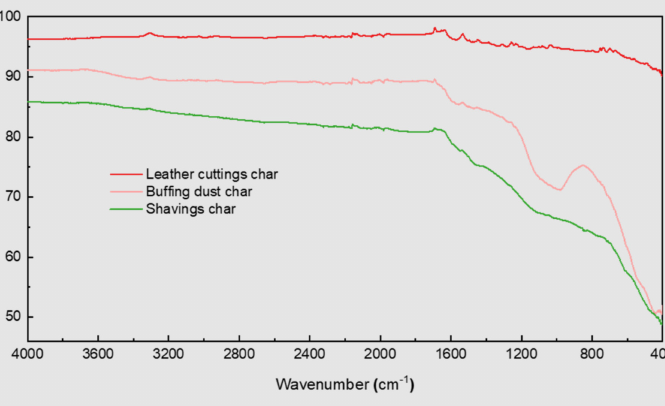
Figure 9. FTIR spectra of the char from Cr-containing leather waste samples (Adapted from Nur-A- Tomal, et al. [7]. Reproduced with permission from Springer